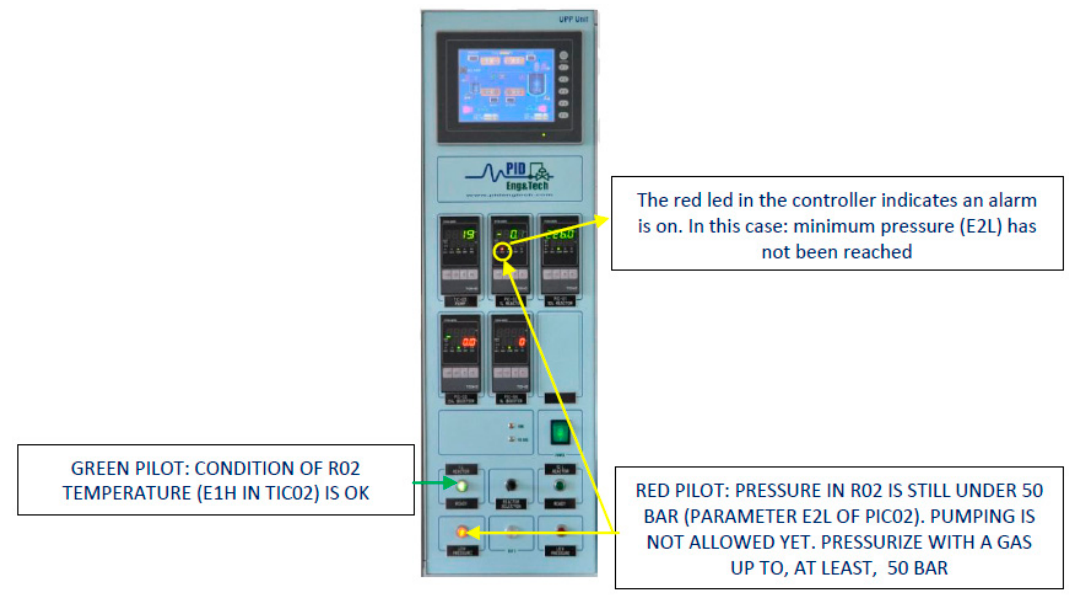
Figure 8. Main control unity showing the main alarm and indication lights.